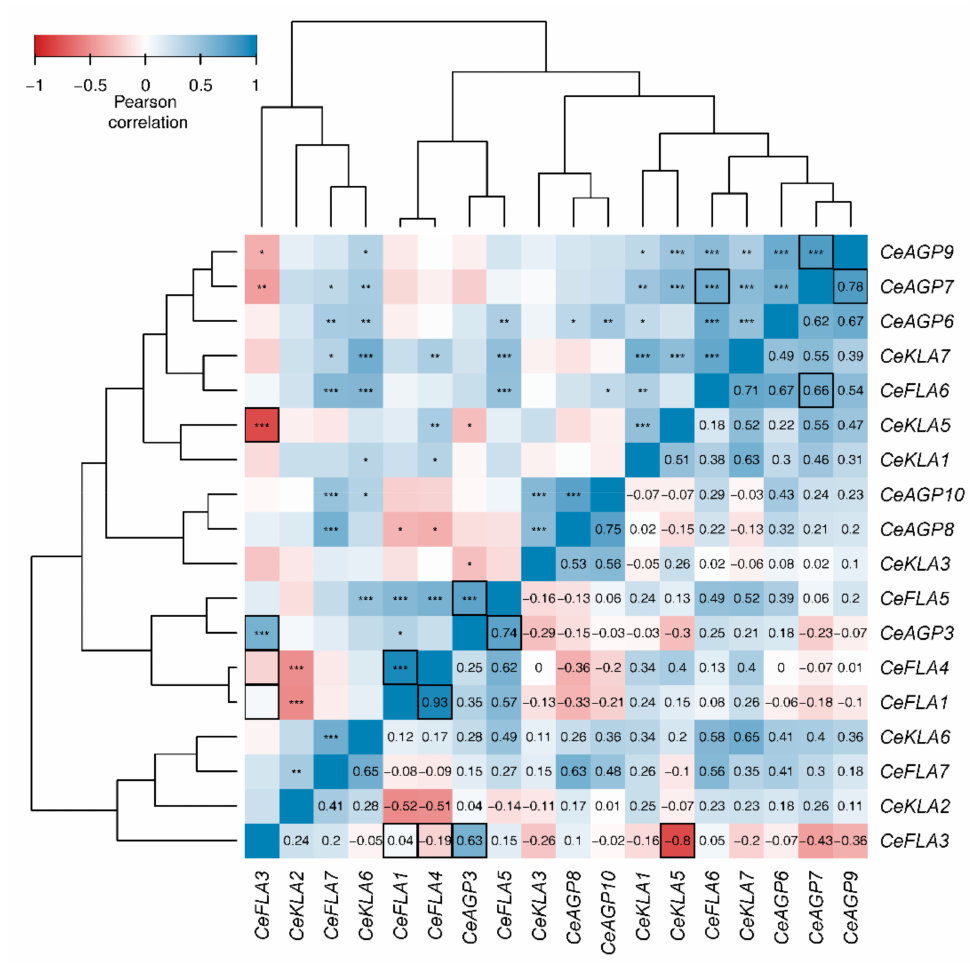
Figure 8. Pearson correlation heatmap of relative gene expression. Pairwise correlation coefficients are given in the lower diagonal triangle, while statistical significance of the pairwise association is shown in the upper triangle: * for p -value < 0.05, ** for p -value < 0.01 and *** for p -value < 0.001. Rows and columns of the heatmap are arranged according to hierarchical cluster analyses performed on a matrix of correlation distances (1–cor Pear ). Cluster agglomeration was performed using complete linkage and the dendrograms are shown on top and left of the heatmap. Emphasized cells (enclosed with rectangles) correspond to the top 5% pairs based on Jackknife bias corrected mutual